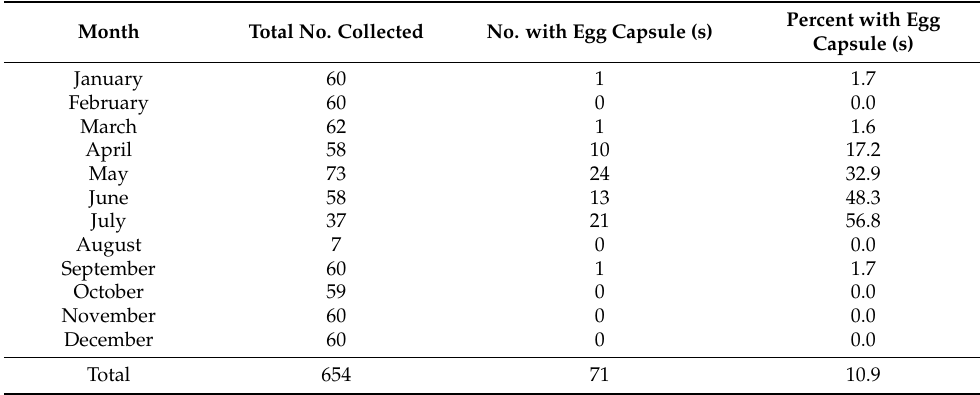
Table 2. Number of egg capsules observed in the gonads of ocellate spot skate Okamejei kenojei specimens collected from the West Sea of Korea in 2019 and 2020. Month Total No. Collected No. with Egg Capsule